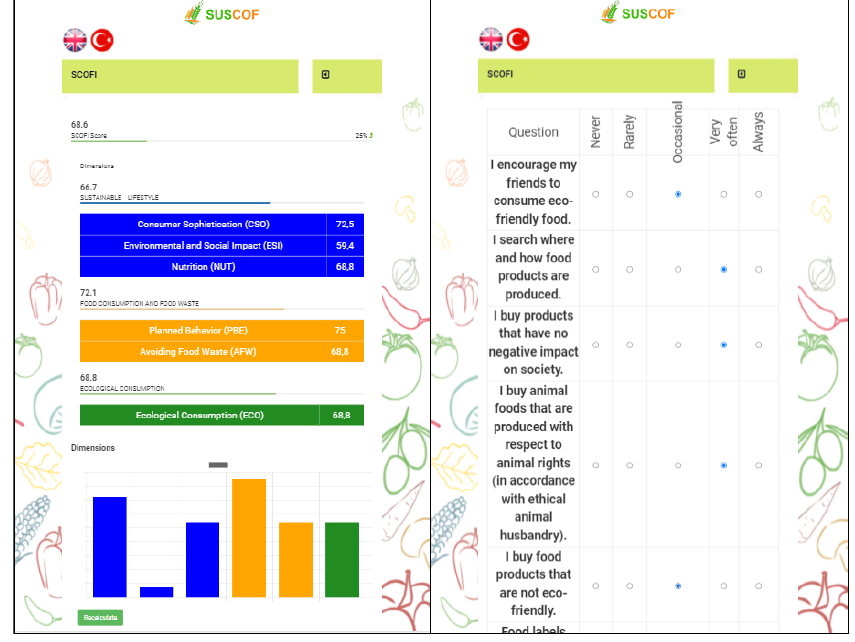
Figure 5. SCOFI Display.